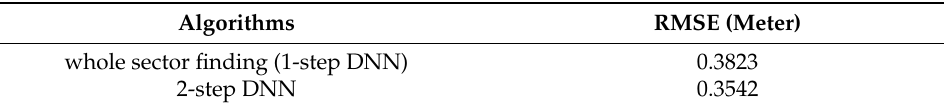
Table 3. RMSE difference between the entire zone and the